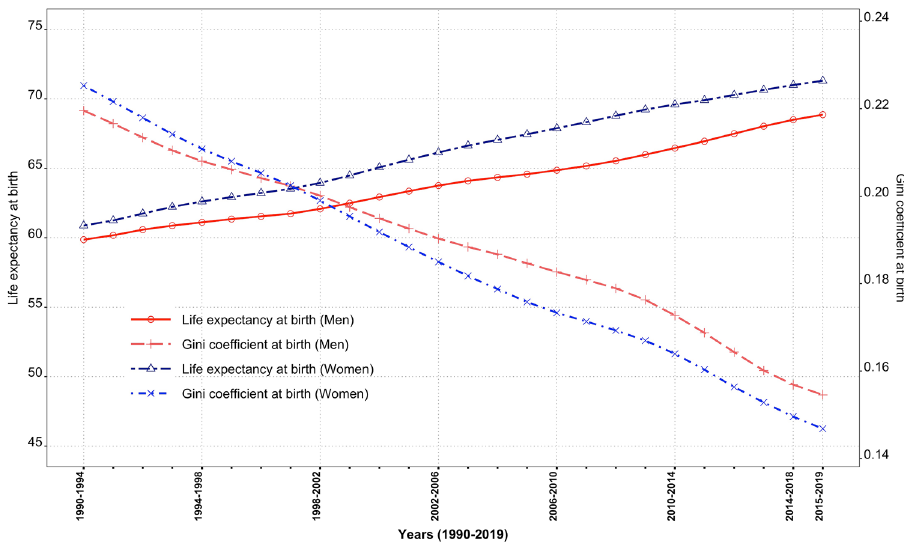
Figure 1. Trends in e 0 and G 0 , men and women, 1990–2019.